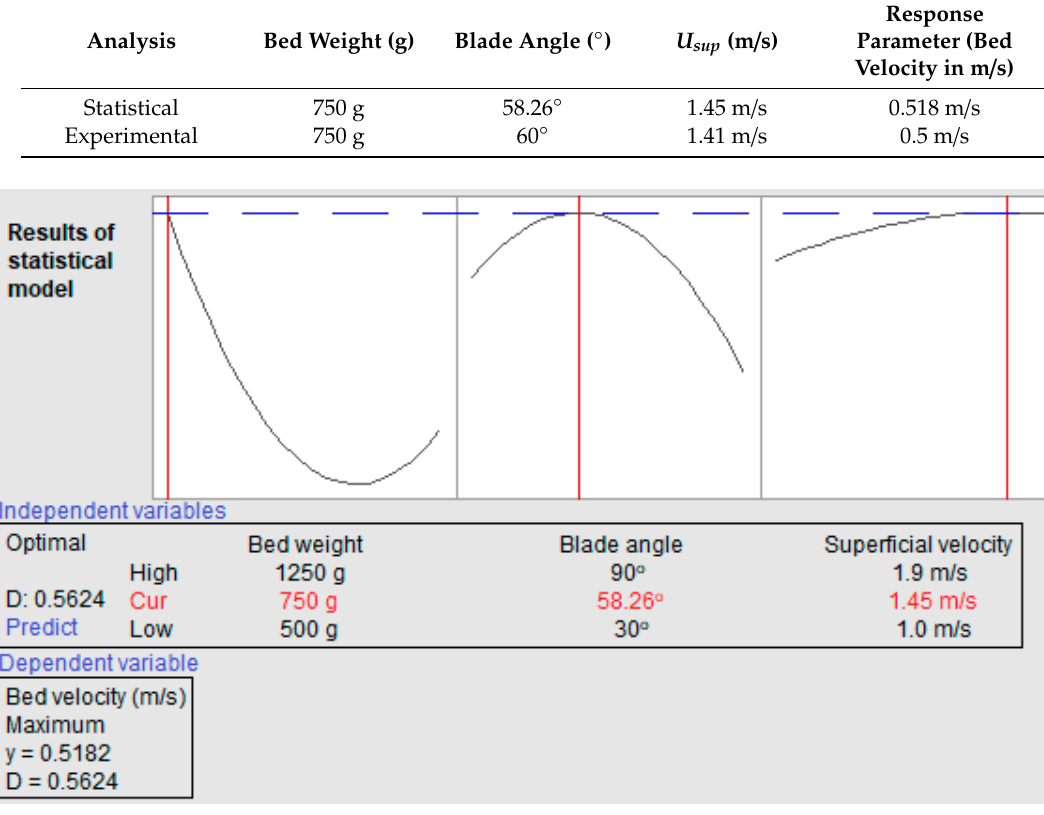
Figure 12. Statistical analysis of response and independent variables.